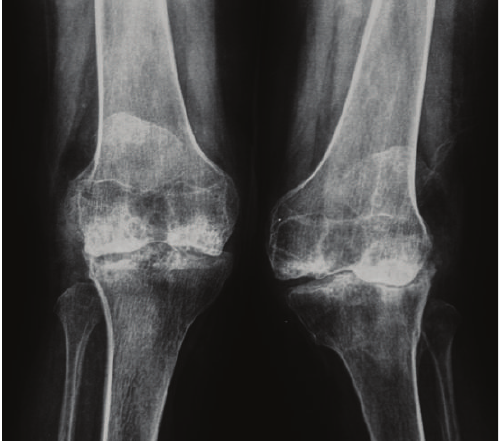
Figure 4: Standing anteroposterior XR of the knees showing genua valga with overgrowth of both medial femoral condyles and severe degenerative